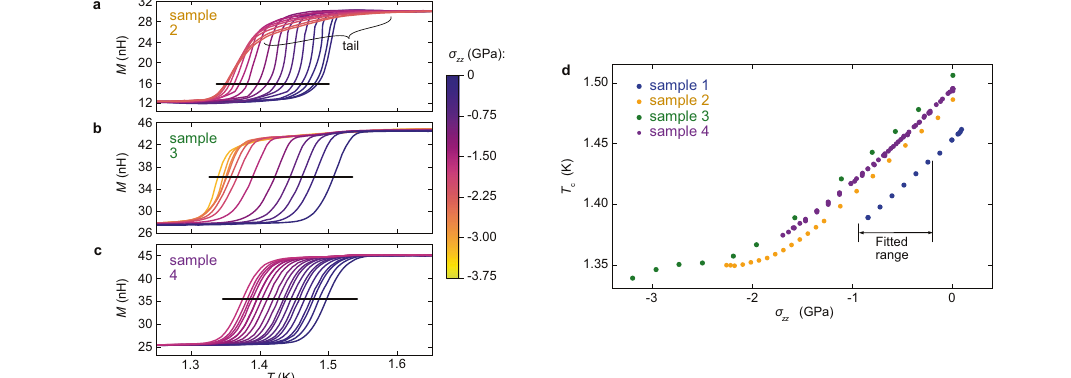
threshold is chosen to avoid this tail. d T c versus stress for all the samples. The stressscalesforsamples1 – 3arescaledtobring dT c / d σ zz intoagreementwiththatof sample 4 over the stress range labeled “ fi tted range ” , − 0.92 to − 0.20GPa.